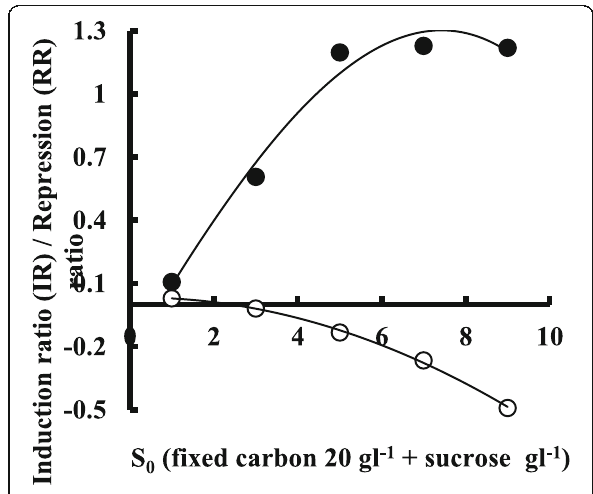
Fig. 2 Exo -polygalacturonase induction or repression ratio at varying level of sucrose with a fixed concentration of pomelo peel powder in submerged ( ○ ) or solid-state fermentation ( ● ) of P.